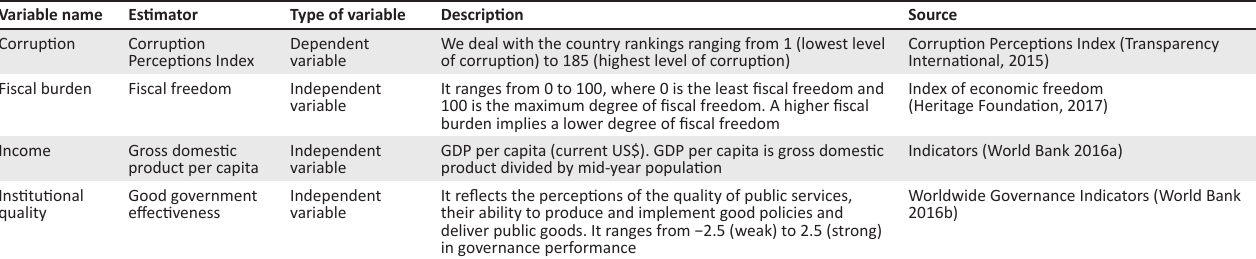
TABLE 1: Variables and data